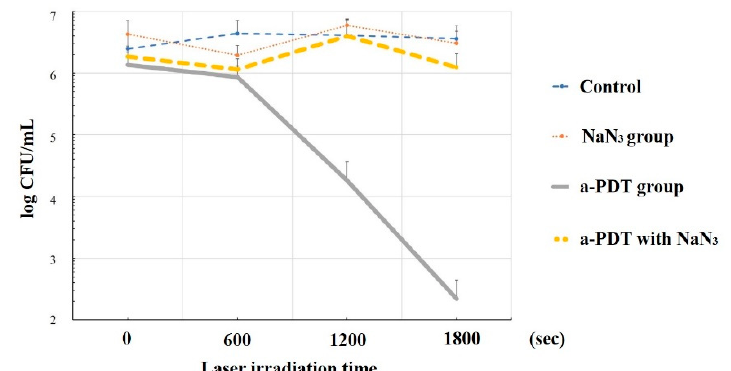
Figure 7. Fungicidal effect of antimicrobial PDT (a-PDT) in 1 O 2 scavenging. A-PDT (same conditions as in Ref. [56]) showed reduced bacterial counts of more than 3-log but no reduction at all under the sodium azide (NaN 3 ) combination. Reprinted/adapted with permission from Ref. [57], 2019, Nihon university society of oral science.